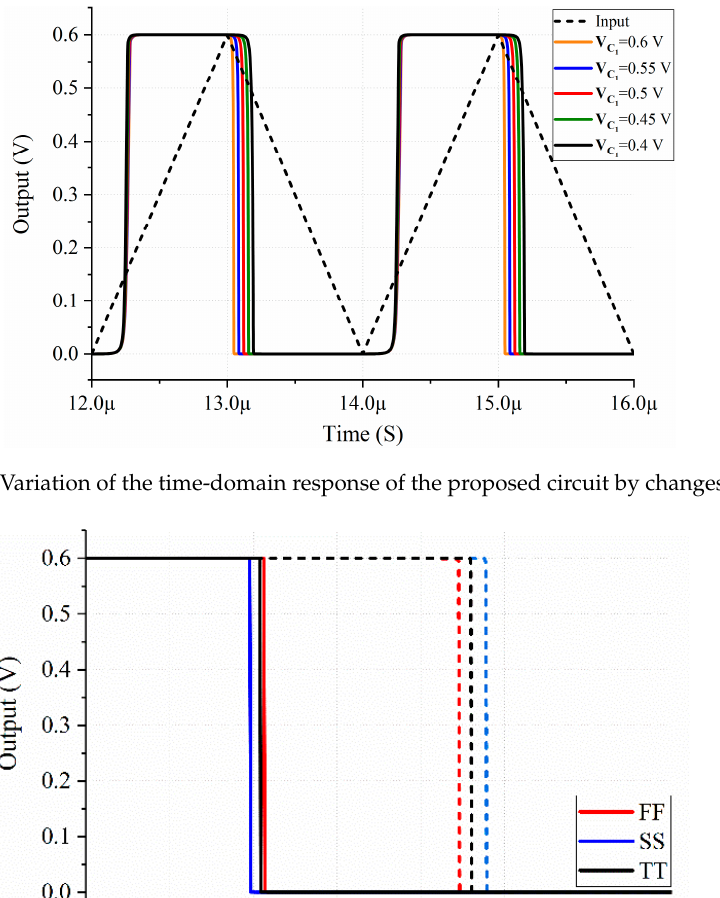
Figure 11. Variation of the hysteresis width in different process corners at 27 degrees Celsius.